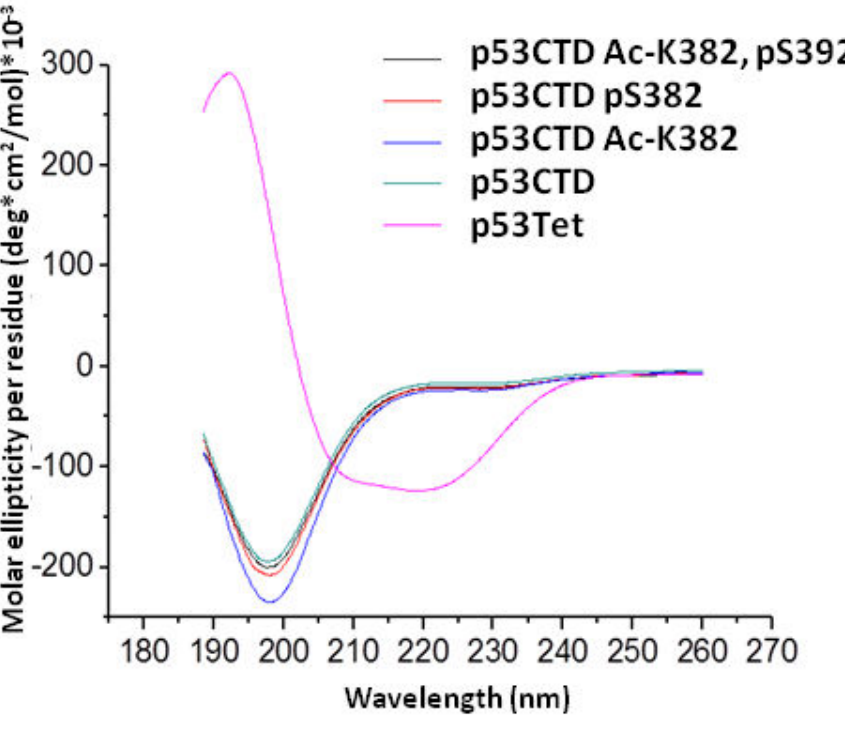
Figure 5. Secondary structure of the CTD of p53. CD spectra of p53 Tet peptide and p53 CTD peptides that are either unmodified, containing both AcK382 and pS392 or containing either AcK382 or pS392. doi: